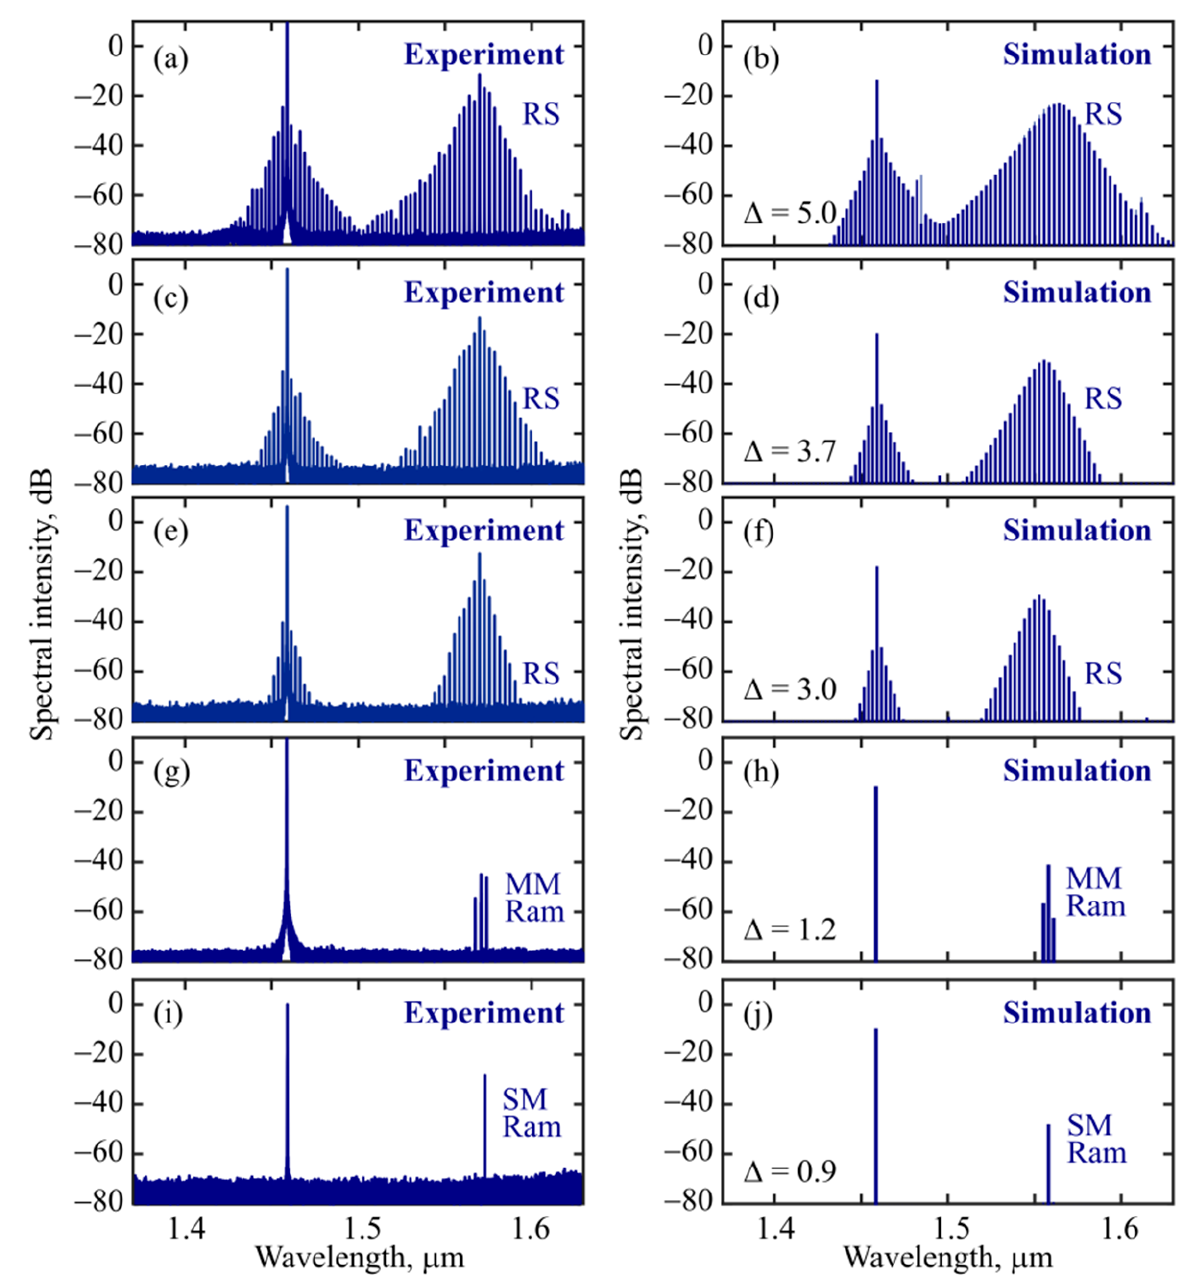
Figure 5. Experimentally measured (left column) and numerically simulated (right column) spectra demonstrating Raman soliton (RS) generation ( a – f ), multimode Raman (MM Ram) generation ( g , h ), and single-mode Raman (SM Ram) generation ( i , j ). Compare pairs ( a – j ). Pump power at 1.46 µ m is constant 12 mW (before the taper) and power of 0.98 µ m auxiliary laser diode is attenuated from 200 mW (at the beginning of the experiment, when there is no Raman generation) to: 80 mW ( a ), 65 mW ( c ), 50 mW ( e ), 20 mW ( g ), and 0 mW ( i ).